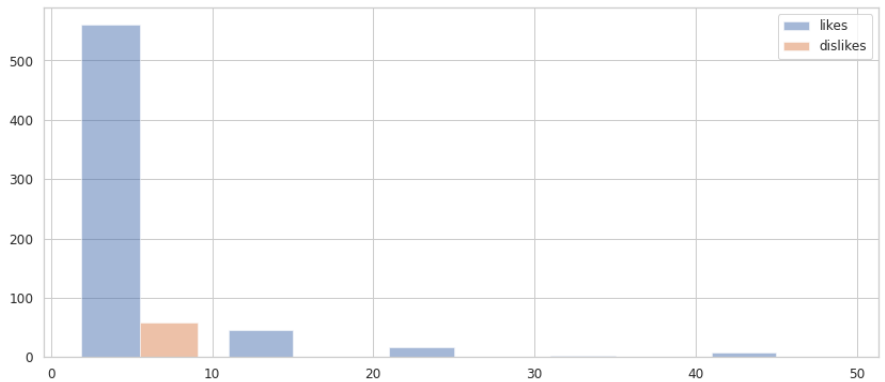
Figure 11. Histogram of views on Odysee videos.